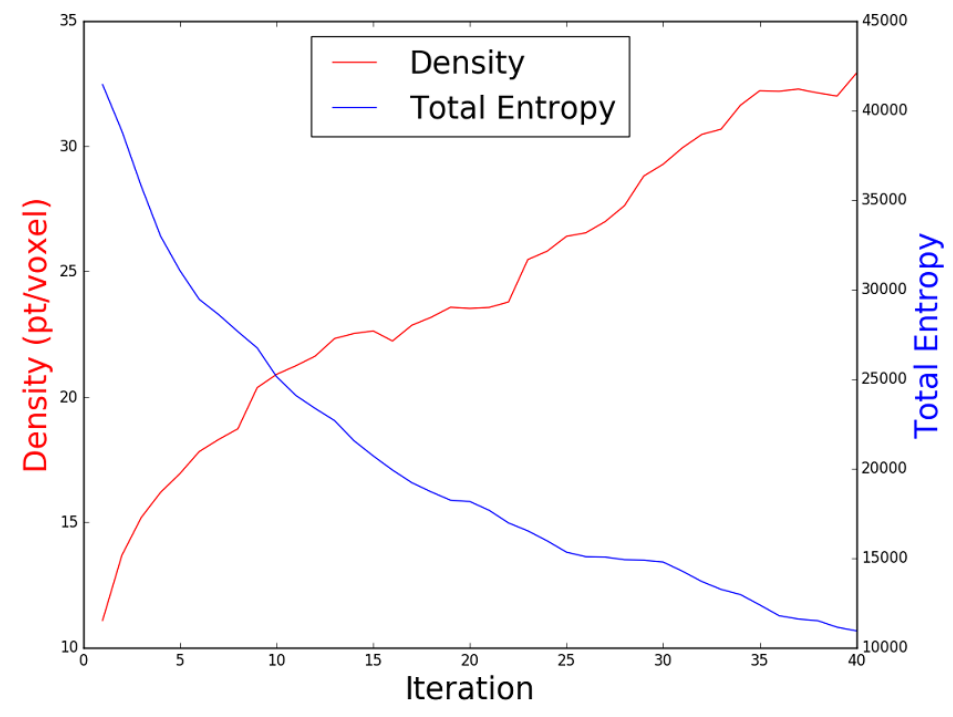
Figure 14. The density and total entropy attributes along the iterations during the indoor real